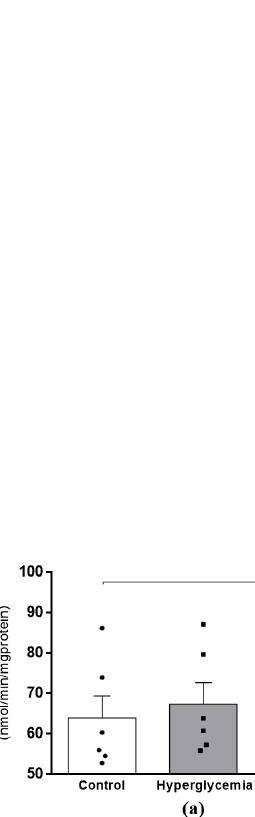
Figure 1. Effects of long-term hyperglycemia and insulin-induced recurrent hypoglycemia in the expression levels of brain glucose and monocarboxylate transporters. Western blot analyses of ( a ) GLUT1, ( b ) GLUT3, ( c ) GLUT4 and ( d ) MTC2 protein levels after normalization with β-Actin. Bars in graphs represent the mean ± SEM of the quantification of brain cortical samples from 4–6 rats under each condition. Representative immunoblots for β-actin are shown as loading control (for uncropped images of the Western blots, please see Supplementary data). A * p < 0.05 was considered as a statistically